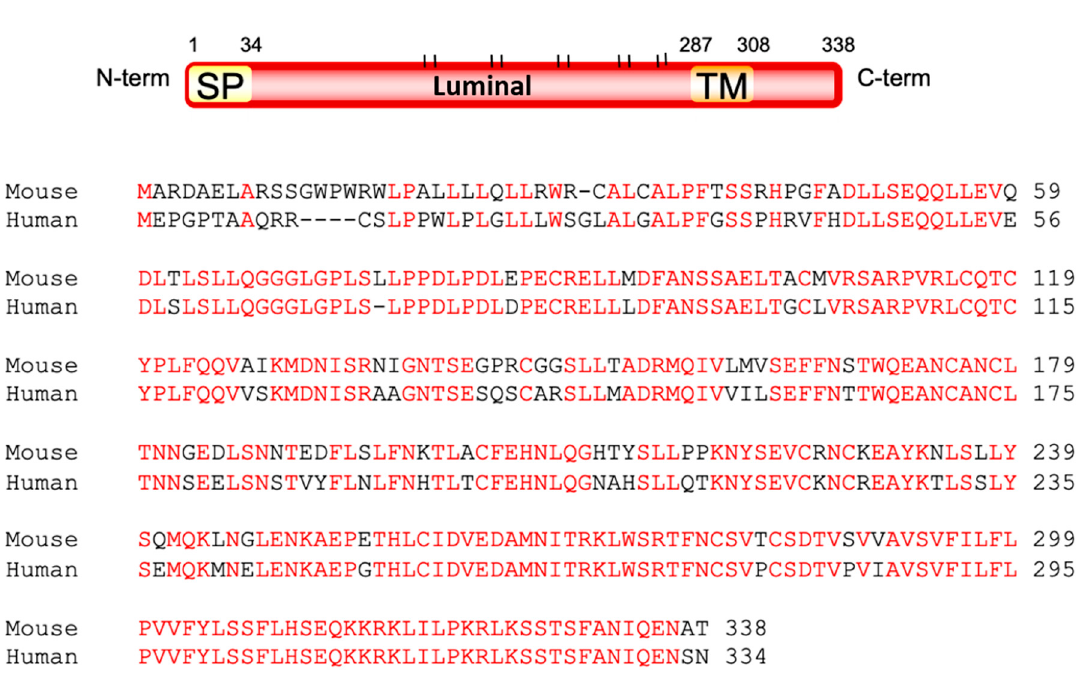
Figure 2. Structure of the murine Ostm1 protein and conservation between the mouse and human proteins. SP: Signal peptide; TM: Trans membrane domain; |: Glycosylation site.